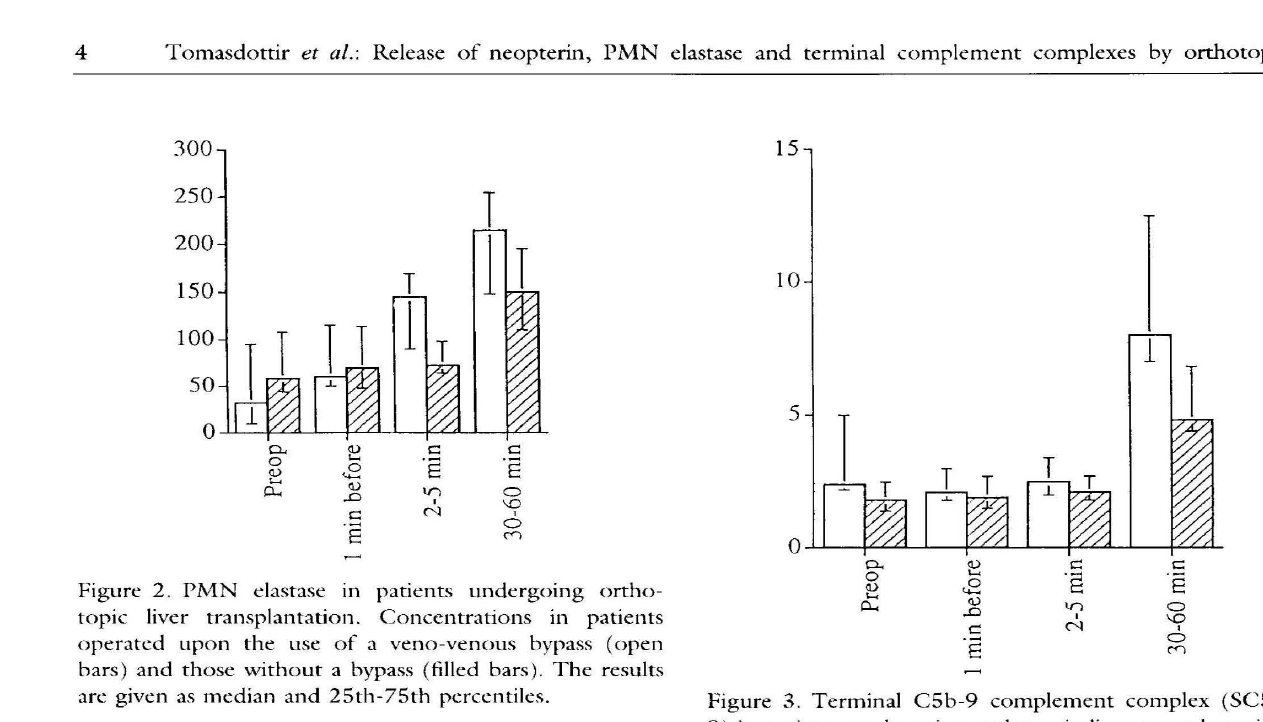
Figure 3. Terminal C5b-9 complement complex (SC5b- 9 ) in patients undergoing orthotopic liver transplantation. Concentrations in patients operated upon the use of a veno-venous bypass (open ars) and those without a bypass (filled bars). Teh results are given as median and 25th-75th